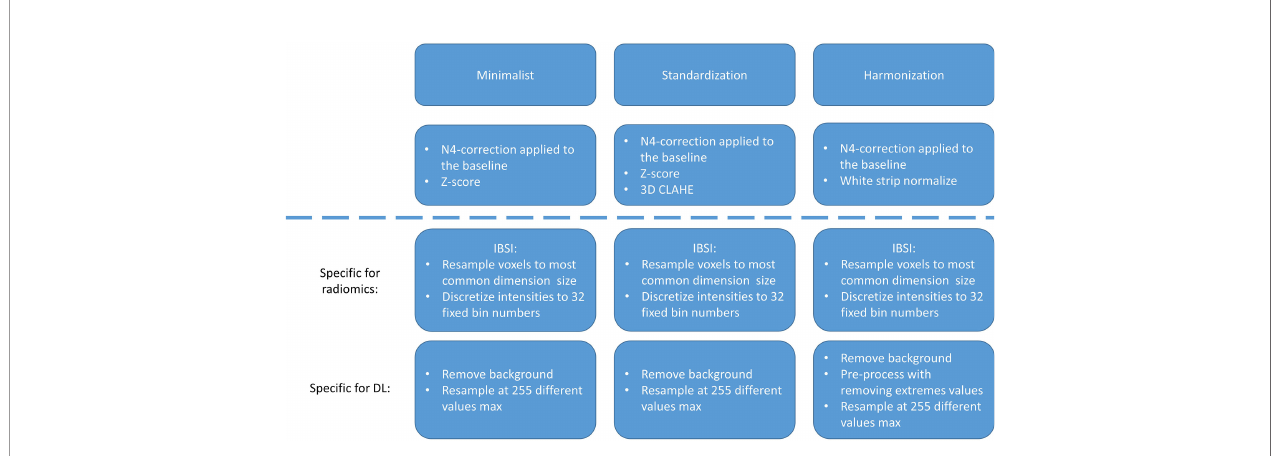
FIGURE 2 | Pre-processing strategies for the “ minimalist ” , “ standardization ” , and “ harmonization ”